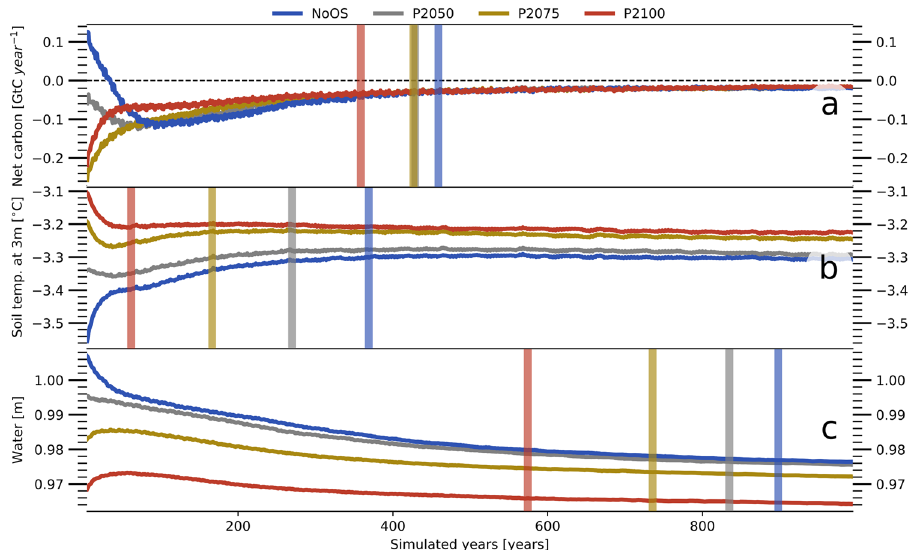
Fig. 2 High-latitude inertia. Shown is the development of key variables under the nontransient atmospheric conditions that arise at the target climate (PACT1.5). a Simulated net ecosystem carbon fl uxes into the atmosphere, b soil temperatures at a depth of 3 m, and c total (liquid and frozen) water content of the soil — in the permafrost-affected areas of the high northern latitudes. Blue lines refer to simulations (NoOS) without previous temperature overshoot (OS), gray lines indicate simulations that started subsequent to an OS with a peak in 2050 (P2050), yellow lines after an OS with a peak in 2075 (P2075) and red lines after an OS with a peak in 2100 (P2100). Shown is the 10-year running mean and solid vertical lines indicate the adjustment timescale. The latter considers the duration until a given variable has largely adapted to the atmospheric conditions — de fi ned by the point at which the rate of change of a given variable has decreased by an order of magnitude ( “ Methods ” ). It should be noted that the analysis is based on the spatial average over the simulated permafrost regions, while individual grid cells can still exhibit substantial trends when the high latitudes as a whole have largely adjusted to the steady atmospheric conditions (see below).